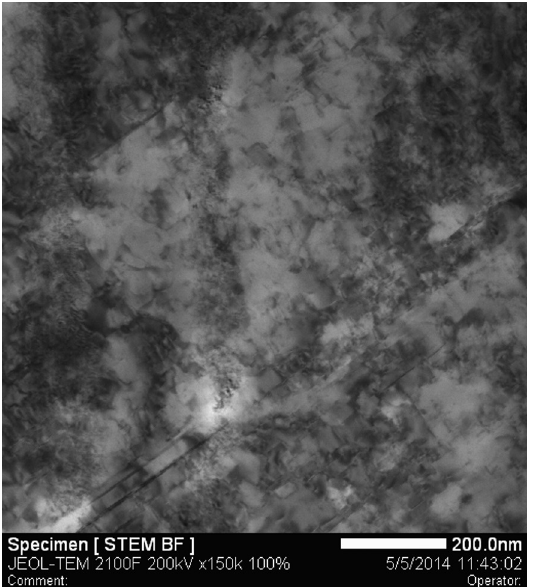
Figure 4. ODF from B2X sample, showing cub (C) and brass (B) texture components. Figure 2. STEM micrograph from B85 sample.